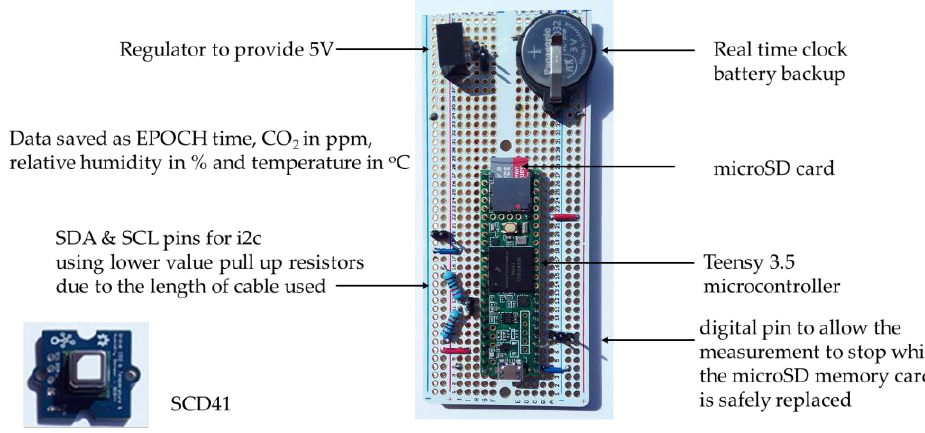
Figure 2. Data logging electronics based on Teensy 3.5 microcontroller. The SCD41 NDIR sensor is shown bottom left mounted on the Grove breakout board.